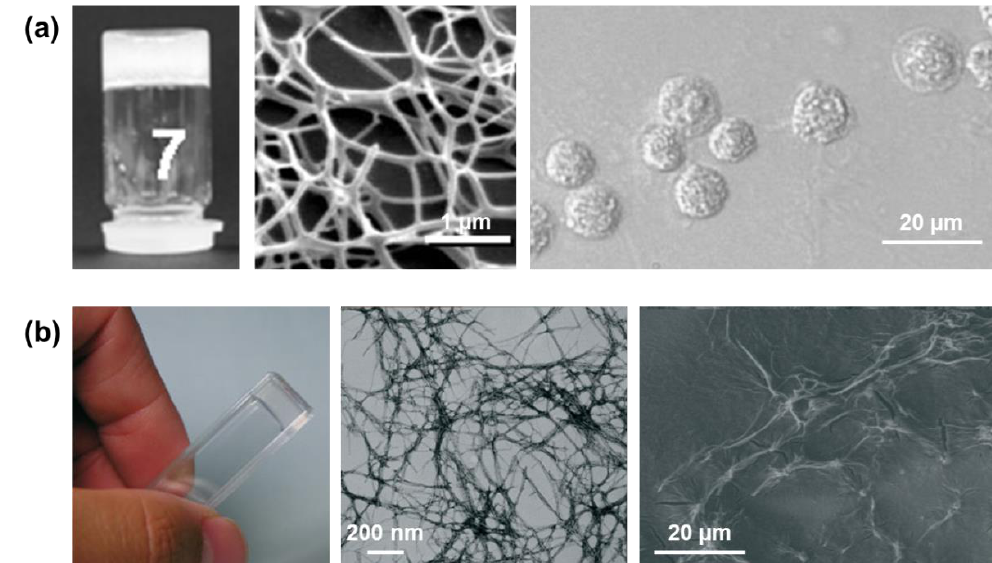
Figure 8. Fmoc-FF hydrogel as simultaneously reported by ( a ) Ulijn and co-workers [44] and ( b ) Gazit and co-workers [45]. ( a ) Glass vial containing the Fmoc-FF hydrogel, labeled as 7 in reference 44 (left), cryogenic SEM image of the hydrogel (middle) and micrographs of cells cultured on the hydrogel (right). ( b ) Photograph of the macroscopic hydrogel (left), TEM image of the fibrous scaffold (middle) and SEM image of the hydrogel (right). Adapted with permission from references 44 and 45.